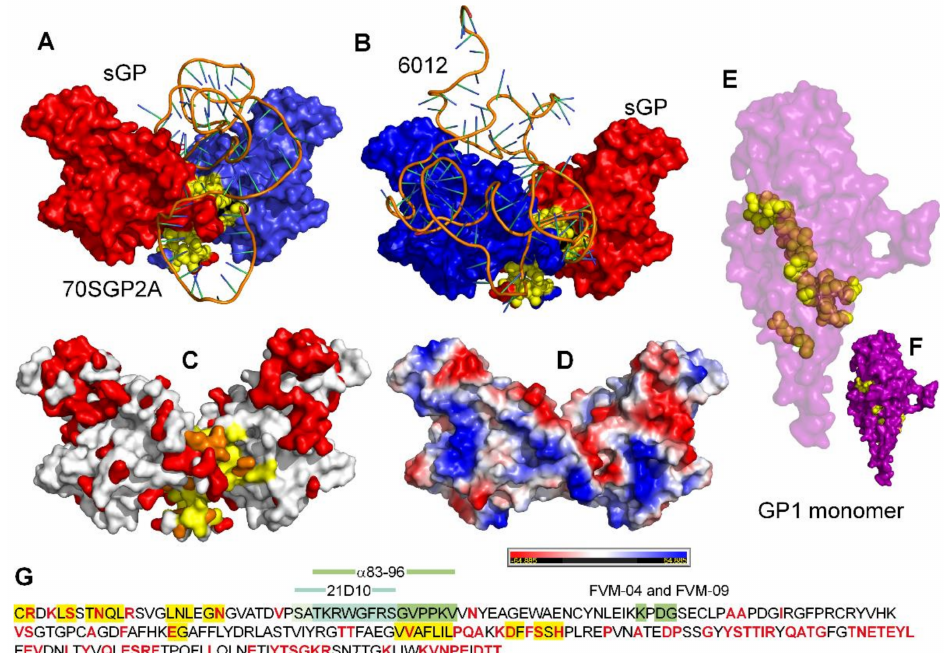
Figure 5. Models that predict the interaction of sGP with DNA aptamers. EBOV sGP (PDB ID 5KEM) showing chain A (red), chain F (blue), and the interface residues of the EBOV sGP dimer (yellow) docked with the predicted 3D structures of ( A ) of 70SGP2A and ( B ) oligonucleotide 6012. ( C ) A comparison of the 3D structures of EBOV sGP (PDB ID 5KEM) and SUDV sGP with conserved residues (white), divergent residues (red), and the interface residues conserved in the EBOV and SUDV sGP dimer as yellow and divergent interface residues as orange. ( D ) The electrostatic potential surface of EBOV sGP (PDB 5KEM). Blue residues are positively charged, red residues are negatively charged, and white residues are neutral. ( E ) All interface residues of the EBOV sGP dimer residues, including surface exposed (yellow) and buried (brown) in the GP1,2 monomer (PDB ID 5KEN). ( F ) Only the interface residues of the EBOV sGP dimer residues that are exposed on the GP1,2 monomer surface (yellow). ( G ) The primary sequence of mature EBOV sGP with divergent residues in red and the interface residues highlighted in yellow. The known antibody epitopes are identified by green highlighting, and their positions on the 3D structure are shown in Figure